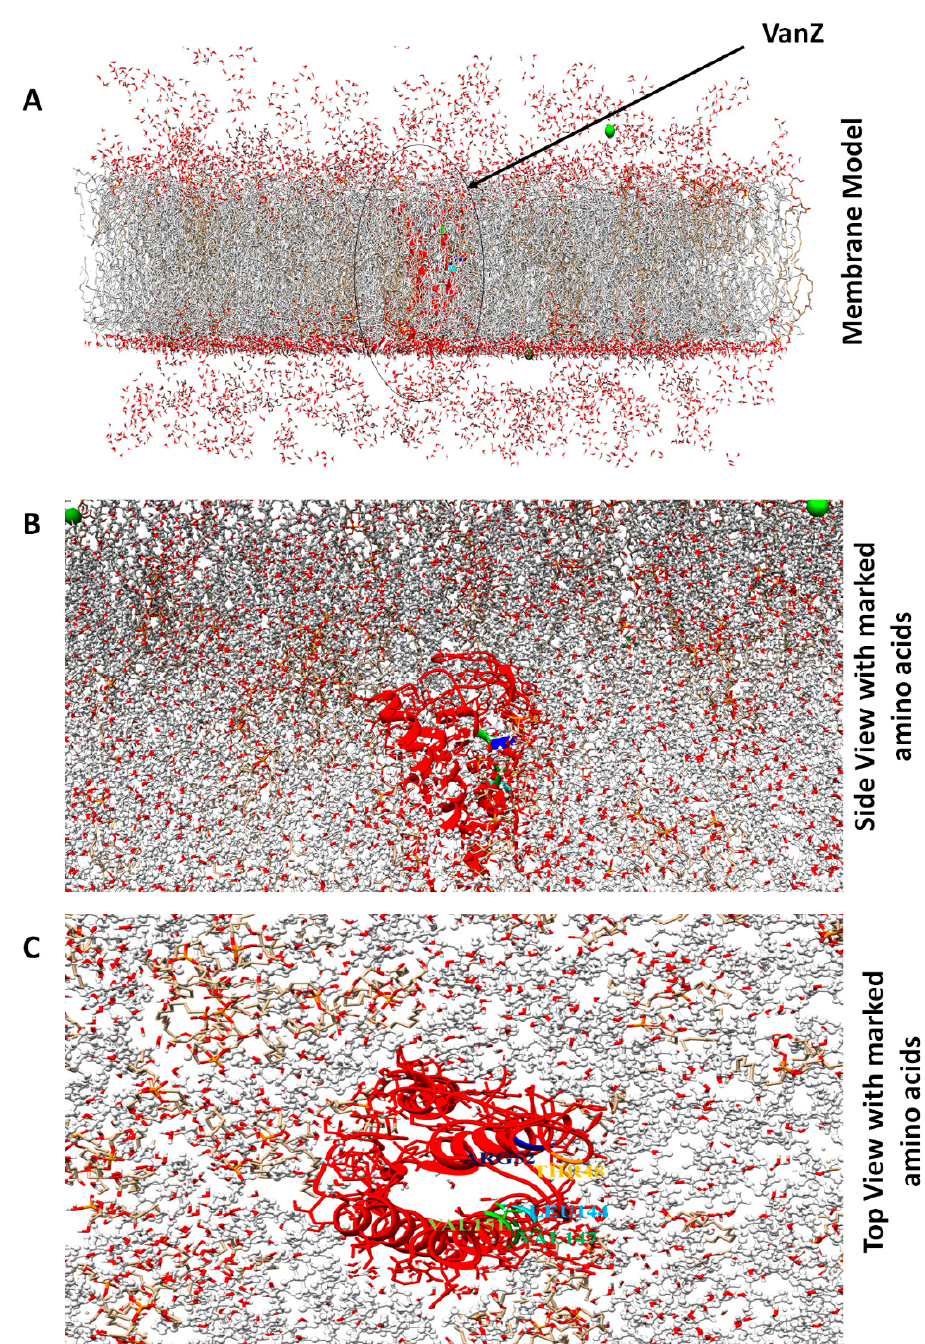
Figure 3. Bacterial protein-membrane model prepared by the CHARMM-GUI web-based modeling platform. ( A ): The VanZ protein is embedded in the bacterial membrane system. ( B ): VanZ (close side view) with color-marked interacting amino acids embedded in the bacterial membrane system. ( C ): VanZ (top view) with color-marked interacting amino acids initiating in G3K ligand interaction.